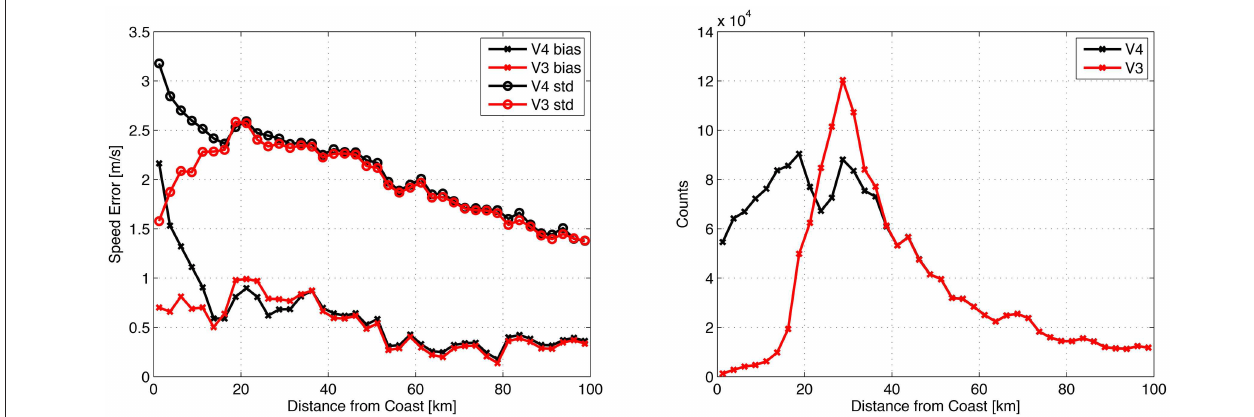
FIGURE 1 | QuikSCAT Coastal performance (left) for versions 3 (red) and 4 (black) showing biases (crosses) and standard deviations (circles) relative to buoy observations. Version 4 has at least 10 time as many buoy hits within 20km of the coast as version 3 (right). All available NDBC buoys were utilized in this assessment. This may tend to overemphasize near-coastal errors, because some coastal buoys are known to be non-representative of the surrounding wind field. Two trends are apparent. Differences from buoys decrease out to 100-km possibly due to more spatial variance closer to shore. There is a steeper trend from 0 to 20-km perhaps due to residual errors in coastal processing. Agreement 10-km from coast is only marginally worse than 30-40-km. Agreement within 5-km from the coast shows significant degradation. Distance from the coast is included in the product and can be used as a quality flag.